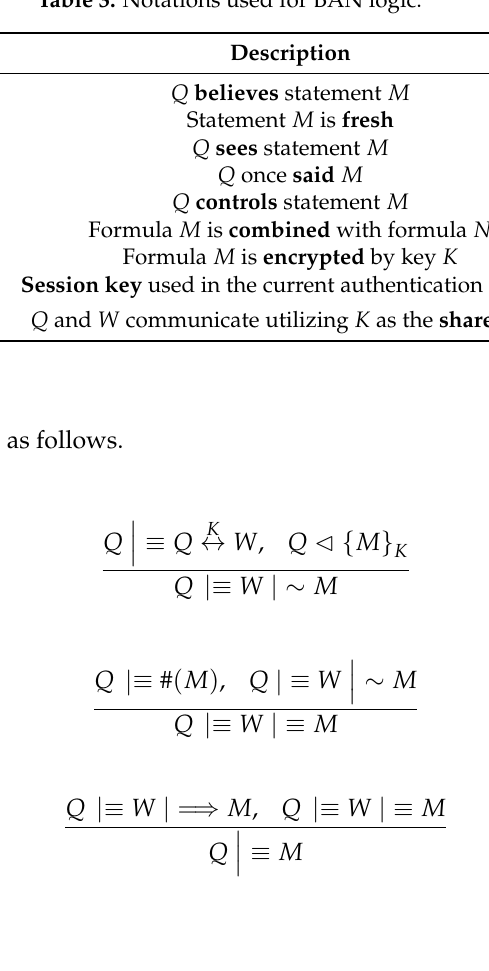
Table 3. Notations used for BAN